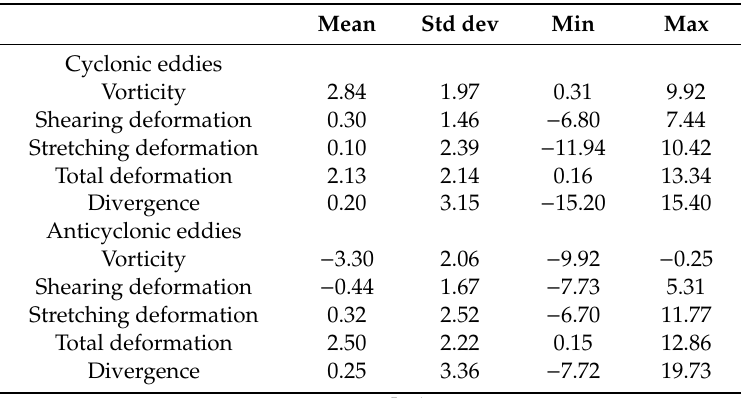
Figure 8. Probability density functions (PDFs) of the various characteristics of the identified submesoscale eddies from HFR-derived velocity fields. ( a , c ): 1-D PDFs for radius and vorticity; ( b ): joint PDF for radius vorticity. Table 1. Mean values of eddy kinematics.